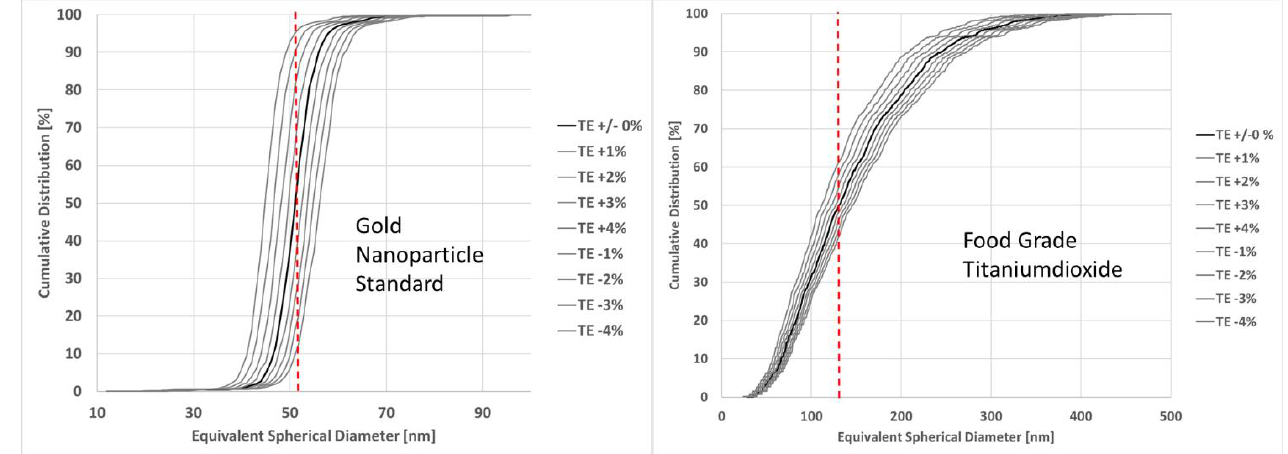
Figure 15. Variations of particle number size distributions as a function of increments/decrements of transport efficiency for a monodisperse and a polydisperse material. The red dashed lines represent the D50 value of the distributions with no TE deviation.